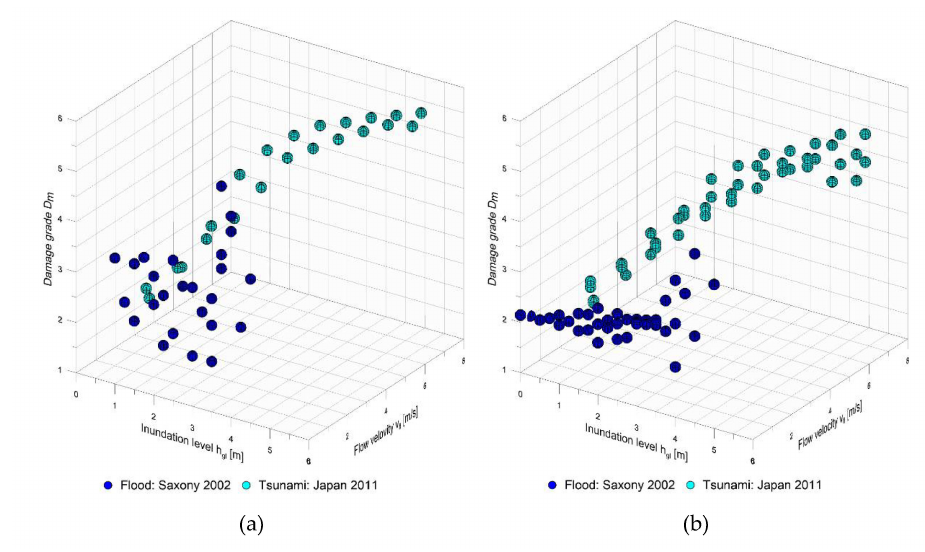
Figure 6. Clustered damage data: ( a ) vulnerability class HW-B; ( b ) vulnerability class HW-C